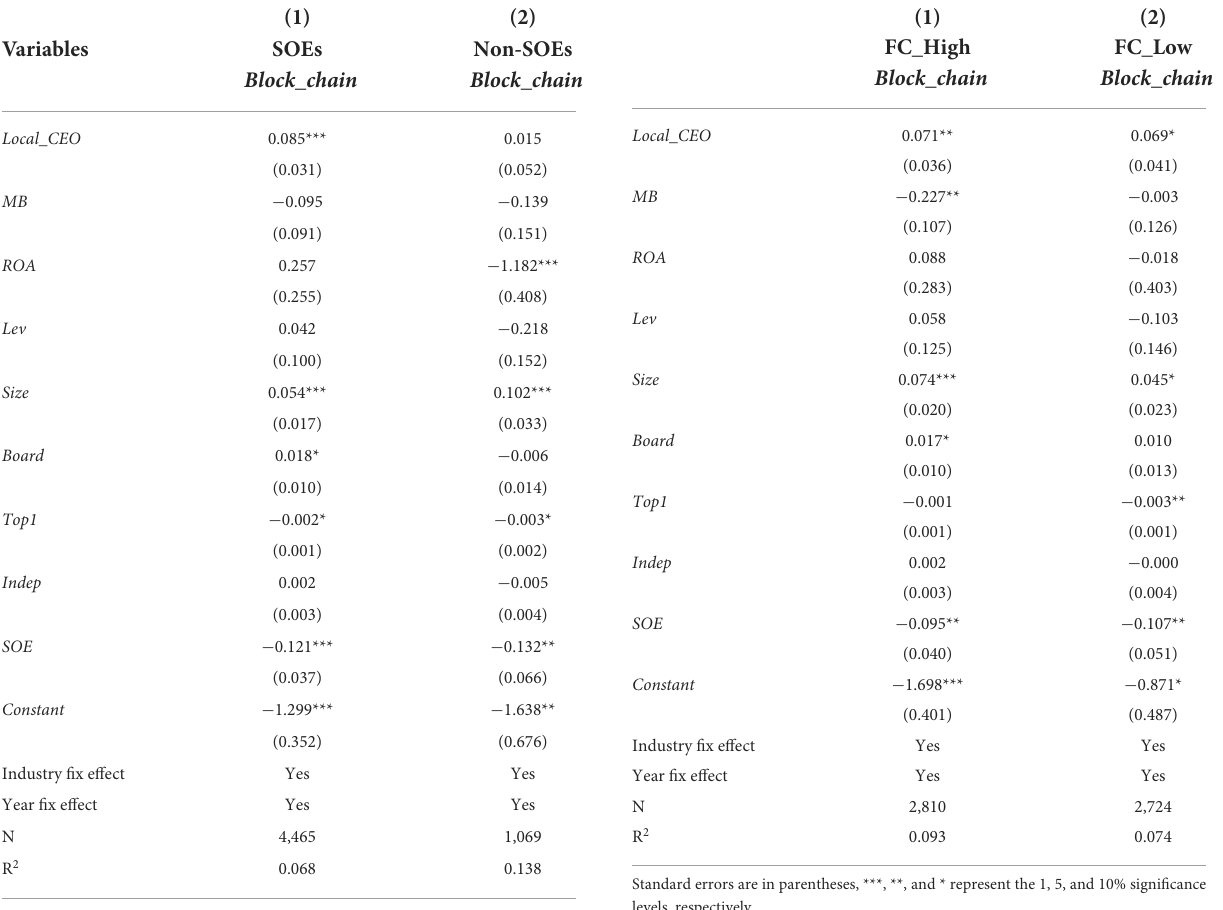
TABLE 6 Test the effect of State-owned enterprises (SOEs). TABLE 7 Test the effect of financing